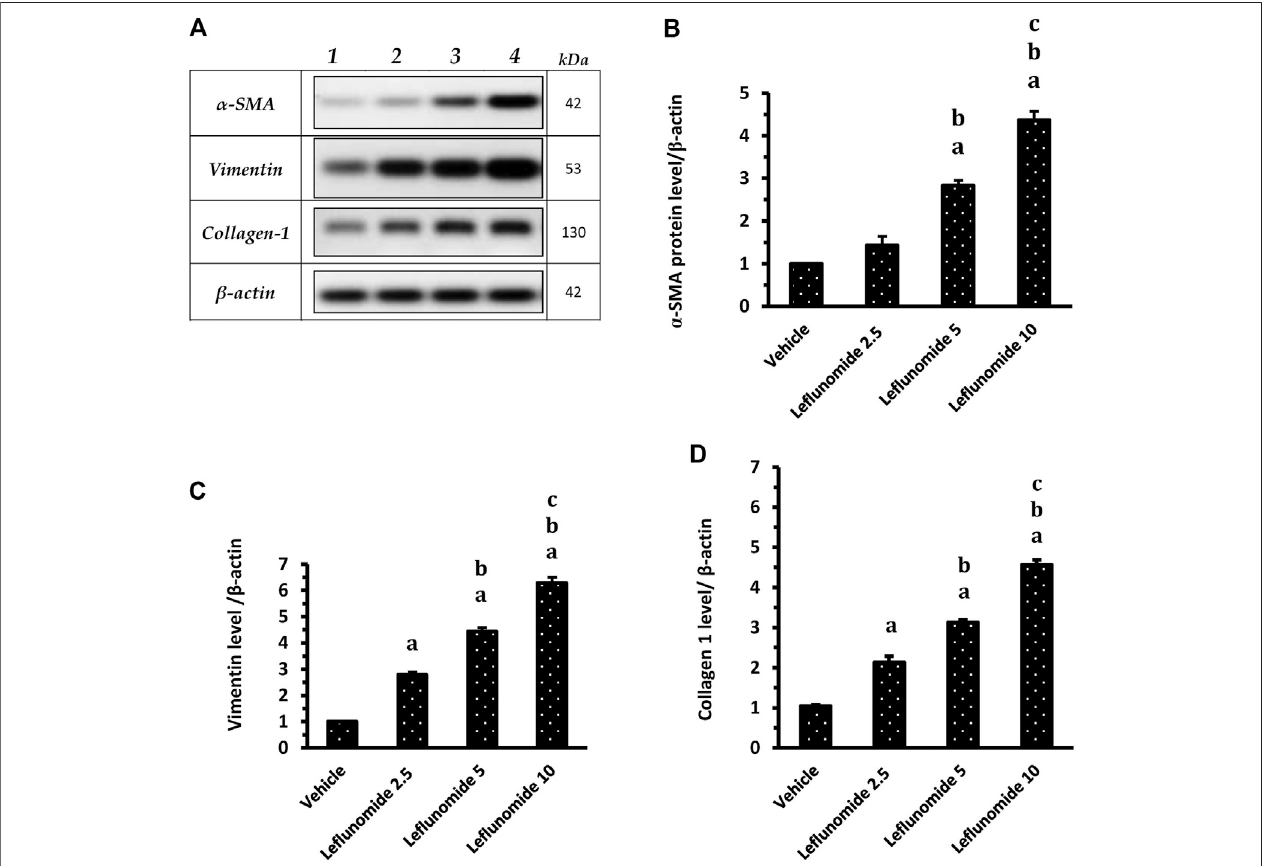
FIGURE 10 | Western blot analysis for α -SMA, vimentin and collagen 1 proteins. (A) : Western blot gels of the target genes in (1) vehicle group, (2) le fl unomide 2.5 mg/kg group, (3) le fl unomide 5 mg/kg group and (4) le fl unomide 10 mg/kg group. ( B – D) : Column charts , vimentin and collagen 1 proteins relative to β -actin. The quanti fi cationdataarepresentedasmean ± SDM. (A) :vs.thevehiclegroup, (B) :vs.le fl unomide2.5 mgperkggroup, (C) :vs.le fl unomide5 mgperkggroupat p < 0.05. α -SMA: α -smooth muscle actin.